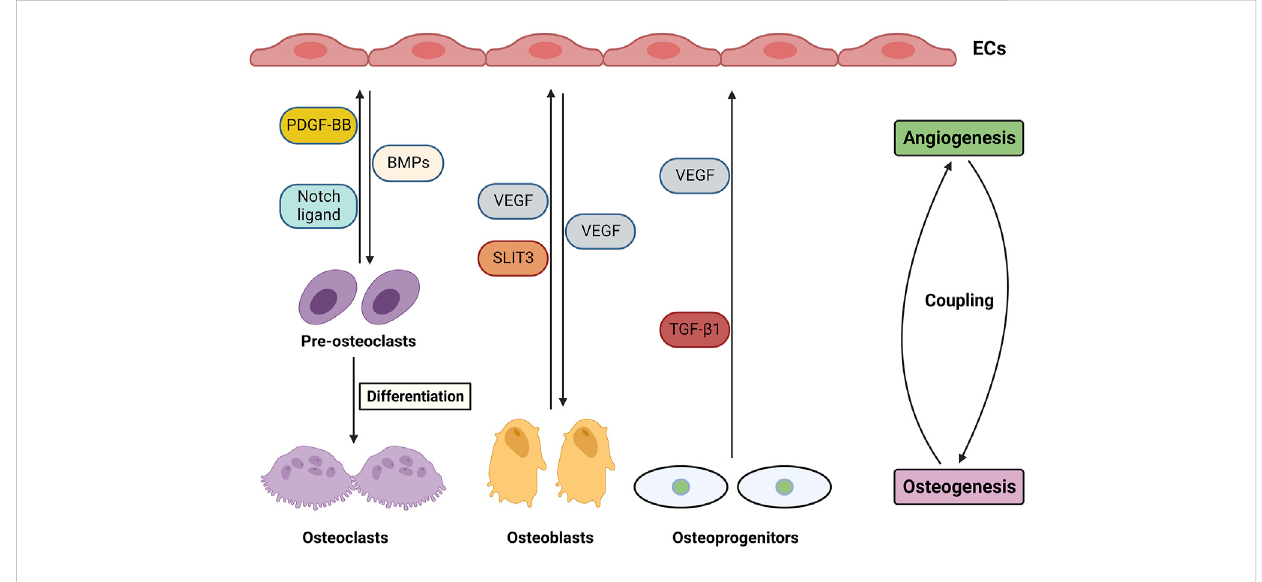
FIGURE 2 Angiogenesis and osteogenesis coupling in bones through cellular and molecular mediators and their